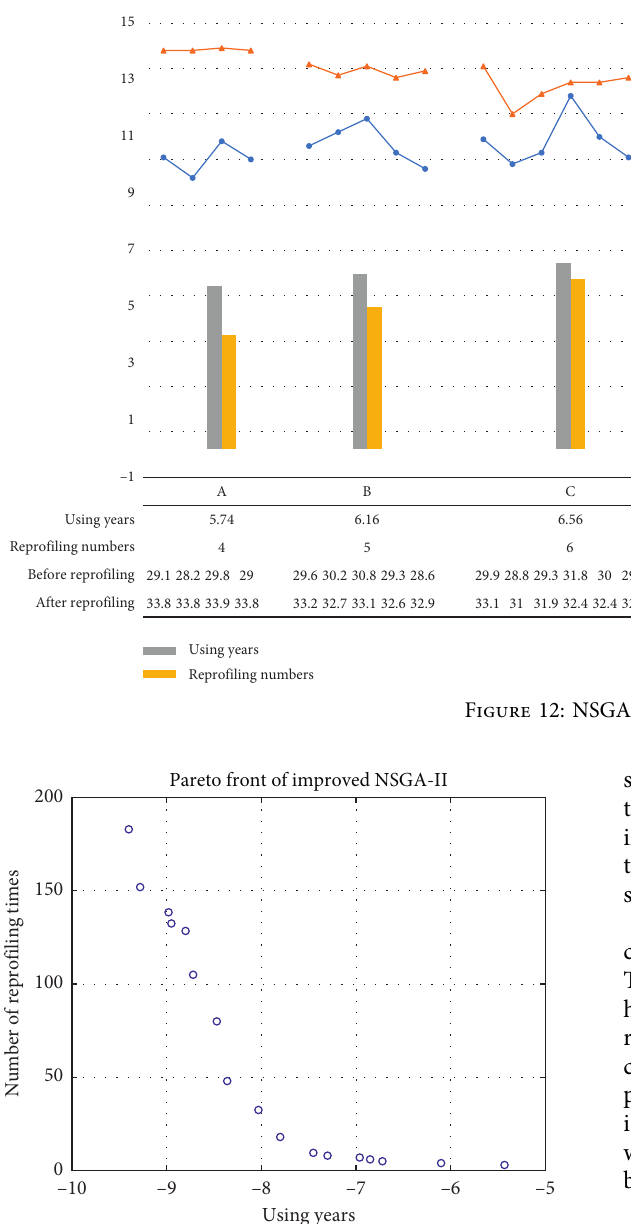
Figure 13: Results of the improved